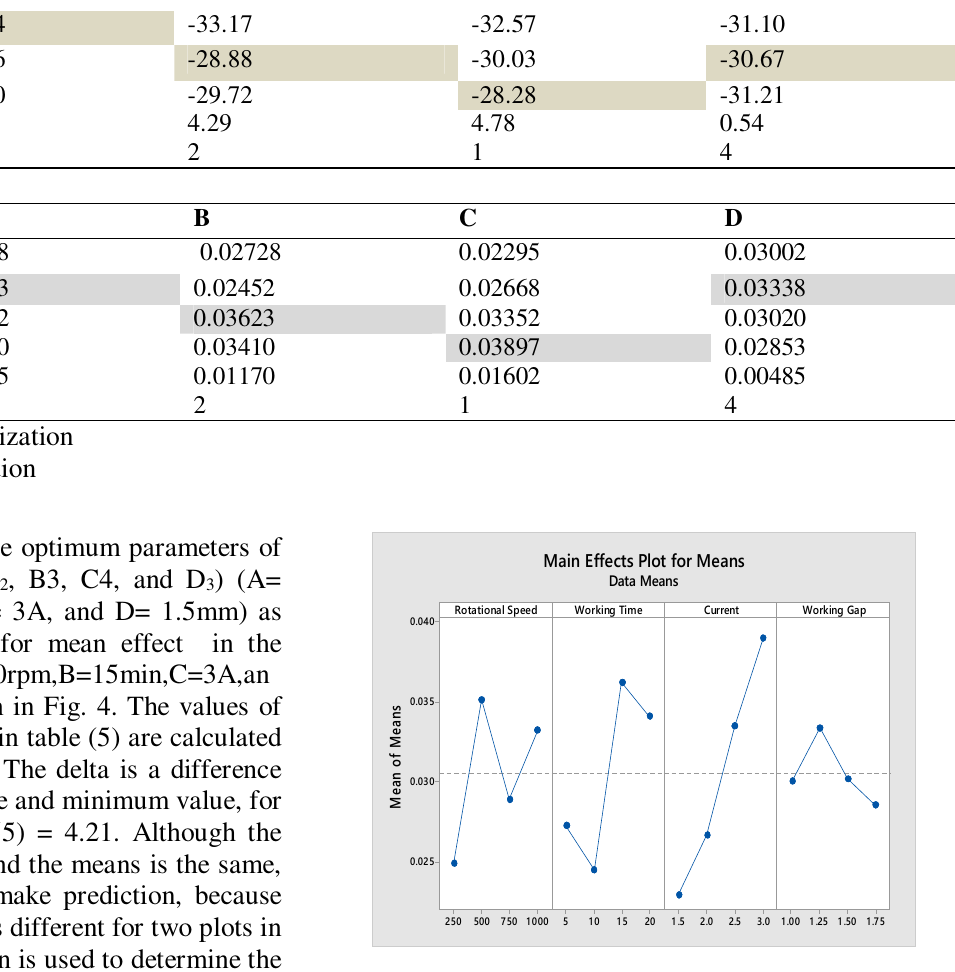
Fig. 4. The mean effect on the parameters of stainless steel 304 on the MRR.